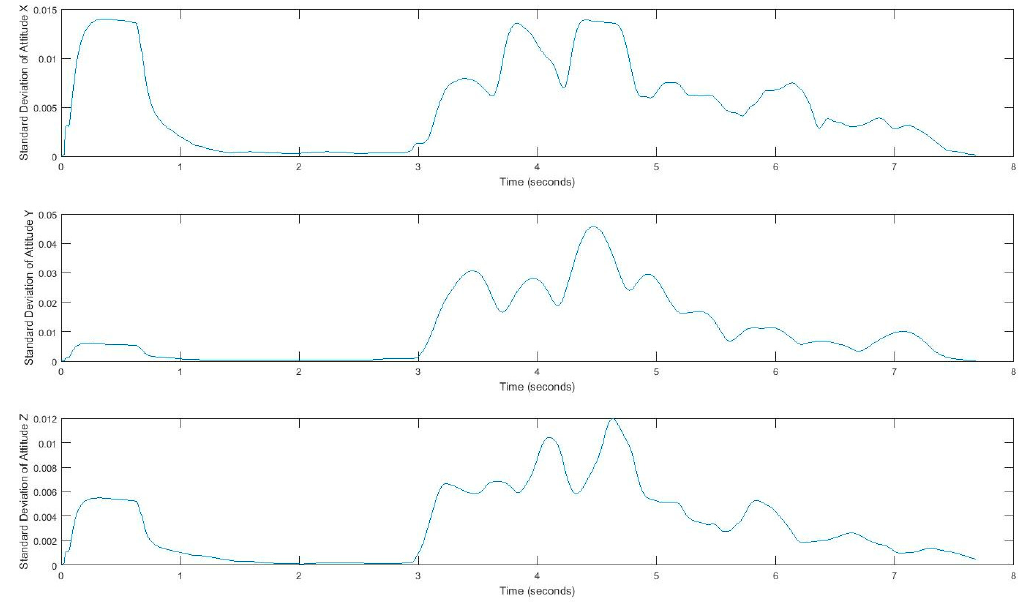
Figure 6. Standard deviation of the attitude signal, computed using a sliding window.